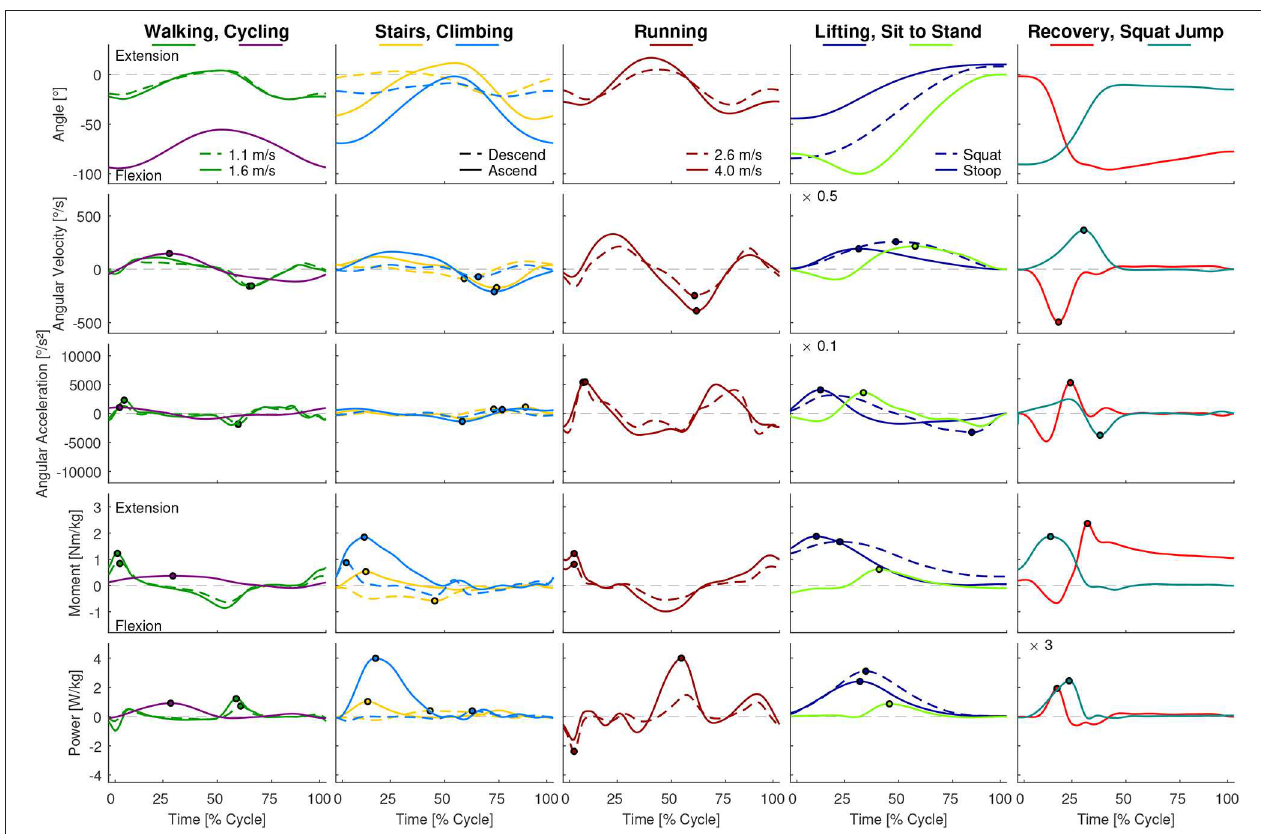
FIGURE 7 | Hip angle, angular velocity, angular acceleration, moment and power for all analyzed movements. Dots indicate the maxima used for Figures 2 , 4 . For visibility some of the graphs were scaled with a factor, which is located at the top left of these graphs. For example, a scaling factor of 0.1 indicates that the y-axis must be multiplied by